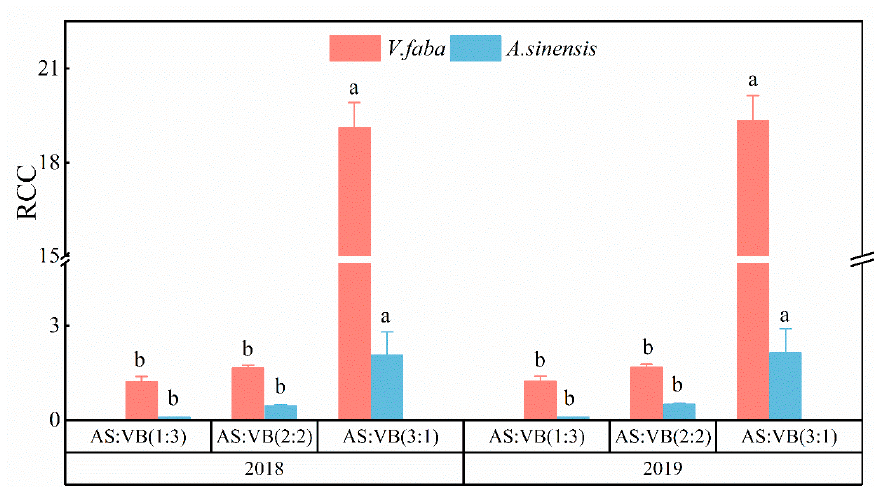
one row of A. sinensis + three rows of V. faba .